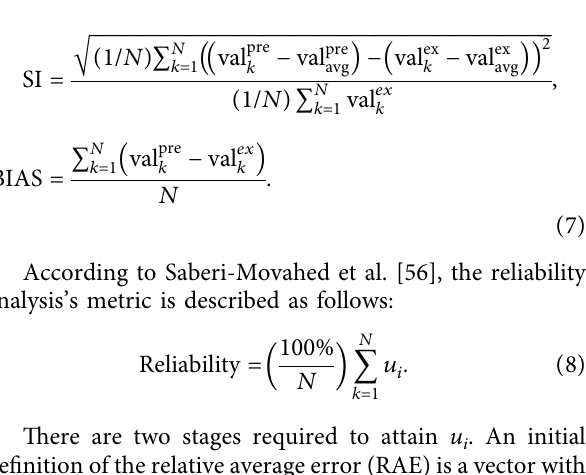
Figure 4: Performance evaluation of 5 machine learning models after 10000 simulations: (a) R 2 , (b) RMSE, (c) MAE, and (d)